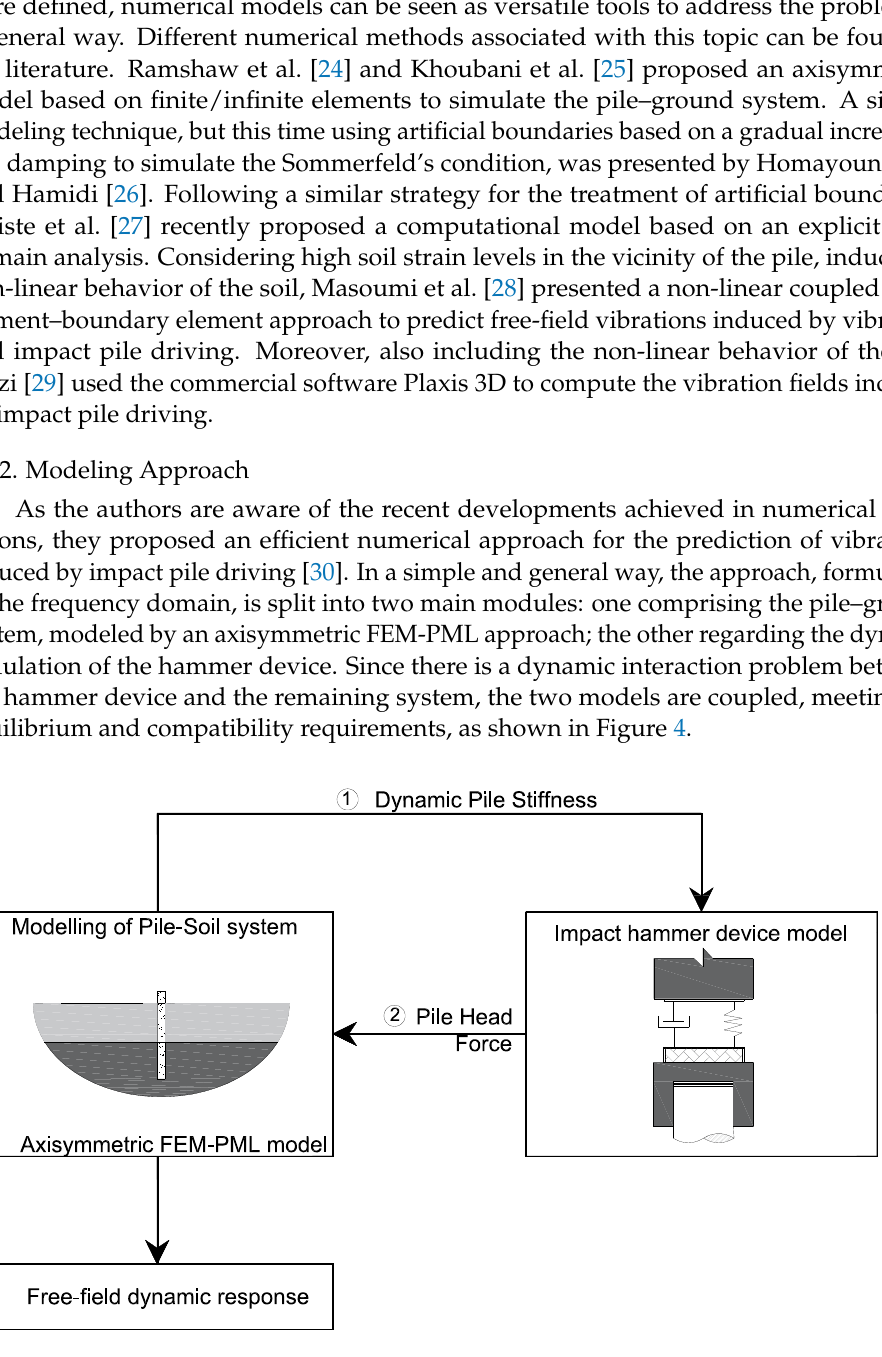
Figure 4. Numerical modeling strategy.